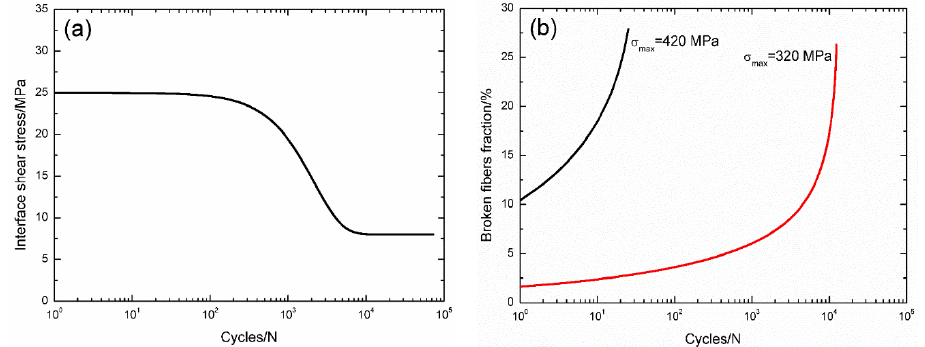
Figure 10. ( a ) The interface shear stress versus applied cycles; ( b ) the broken fiber fraction versus applied cycles; and ( c ) the fatigue life S–N curves of experimental data and theoretical analysis for cross-ply C/SiC composite at 800 °C in air.